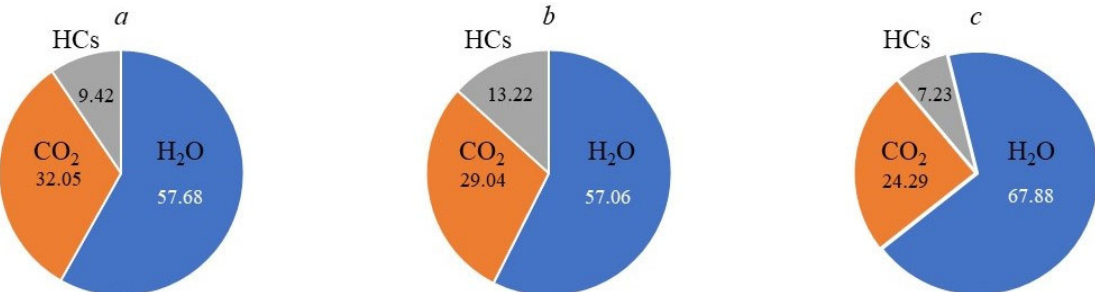
Figure 8. Contents (rel.%) of volatile components ( a ) of the central part (sample 1), ( b ) intermediate part (sample 3), and ( c ) marginal part (sample 6) of a cordierite crystal from the Muzkol metamorphic complex, Tajikistan. HCs are hydrocarbons.